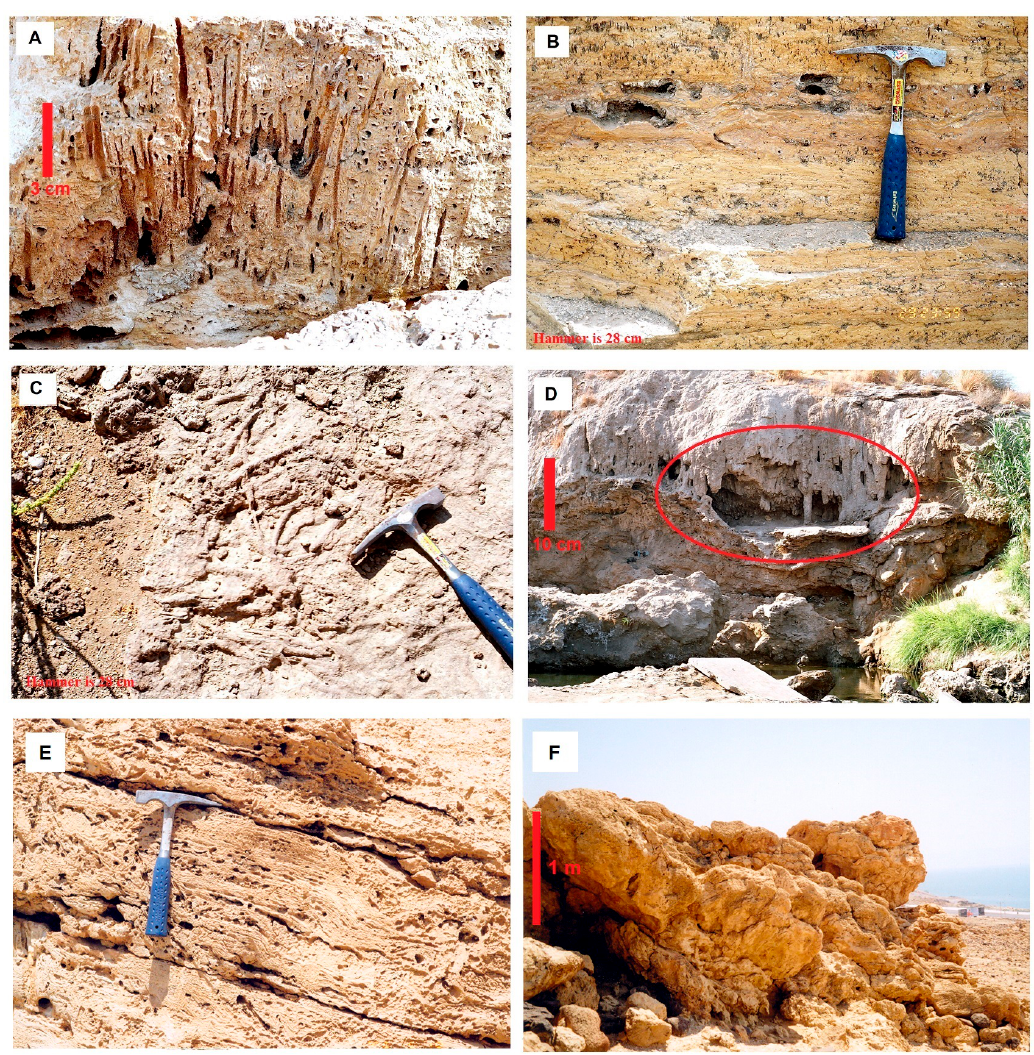
Figure 3. Selected field photos of the studied travertine: ( A ) root casts, downward tapering, rare lateral roots, smooth tube-like, ranging from 0.5 to 7.0 cm in length and from 0.1 to 3.5 cm in diameter preserved in porous travertine from Deir Alla; ( B ) tiny travertine from Deir Alla with irregular elliptical cavities are partly to completely infilled by secondary materials; ( C ) interconnected root traces on the upper bedding plain indicating the plants types of Az Zara area; ( D ) stalagmites and stalactites features (red circle), which are formed near Az Zara hot spring; ( E ) wavy laminae resembles stromatolite in Suwayma travertine, bedding plains indicate three stages of travertine precipitation; ( F ) the mound of travertine standing in an erosional relief in Suwayma. The hammer is 28 cm long.